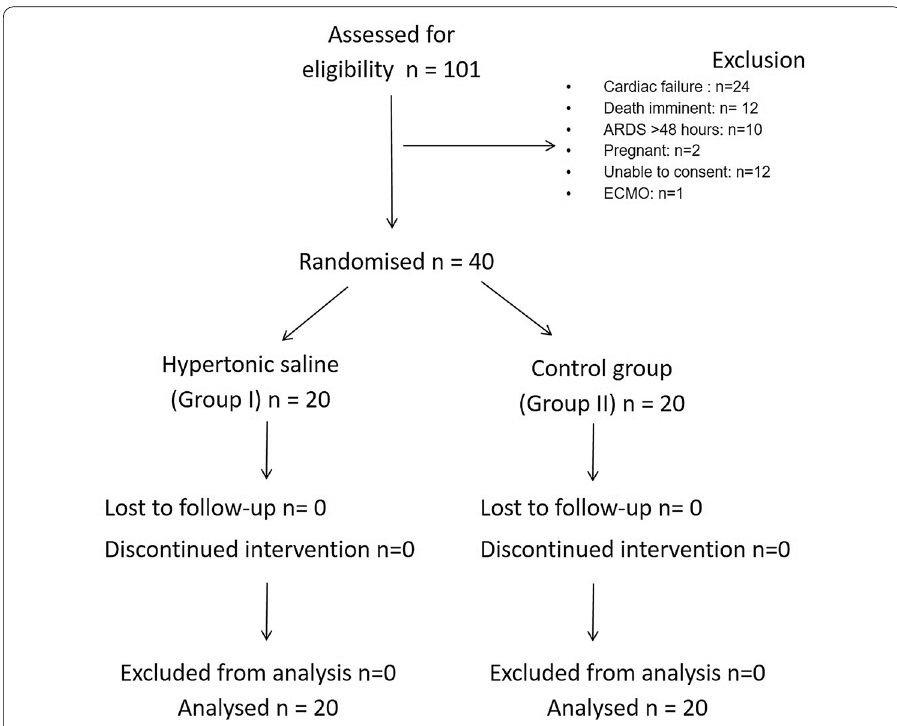
Fig. 1 Consort diagram of patients included in the study